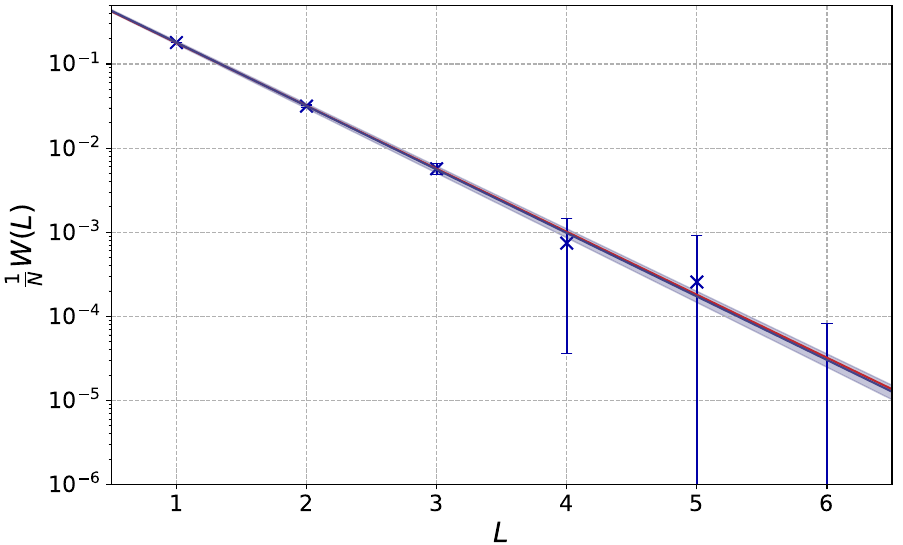
Figure 7. T = 0 . 29 with the constraint P = 0 , allowing us to probe the completely-confined phase near the transition. We have extrapolated to the large N limit using N = 7 , 10 , 16 , 24 , 32 , and to the continuum limit using n t = 16 , 24 , 32 for each N , using the 2D interpolation 1 a con ( L ) + b 1 , con ( L ) + b 2 , con ( L ) + b 3 , con ( L ) . We fitted these interpolated values a con ( L ) for 1 ≤ L ≤ 4 N 2 n t n t N 2 to the ansatz a con ( L ) = exp( − c con L + d con ) , yielding c con = 1 . 738(29) and d con = 0 . 022(31) . The fit is shown along with error bounds by the blue line. The theoretical prediction ( c con = 1 . 724 , and d con = 0 for M = 0 ) is given by the red line, which is mostly obscured by the